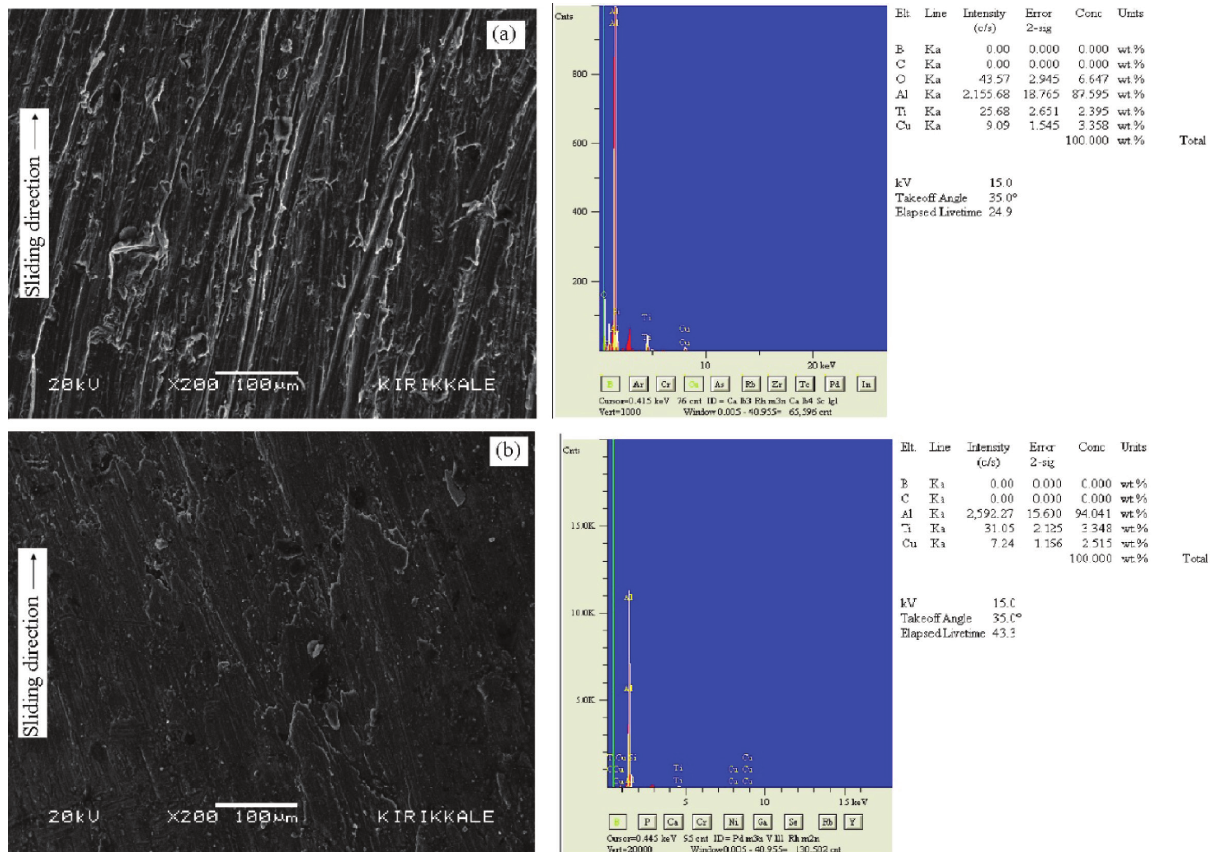
Fig. 10: SEM images of the worn surfaces of the Al 2014-2% TiB 2 and Al 2014-8% TiB 2 composites tested at a load of 30